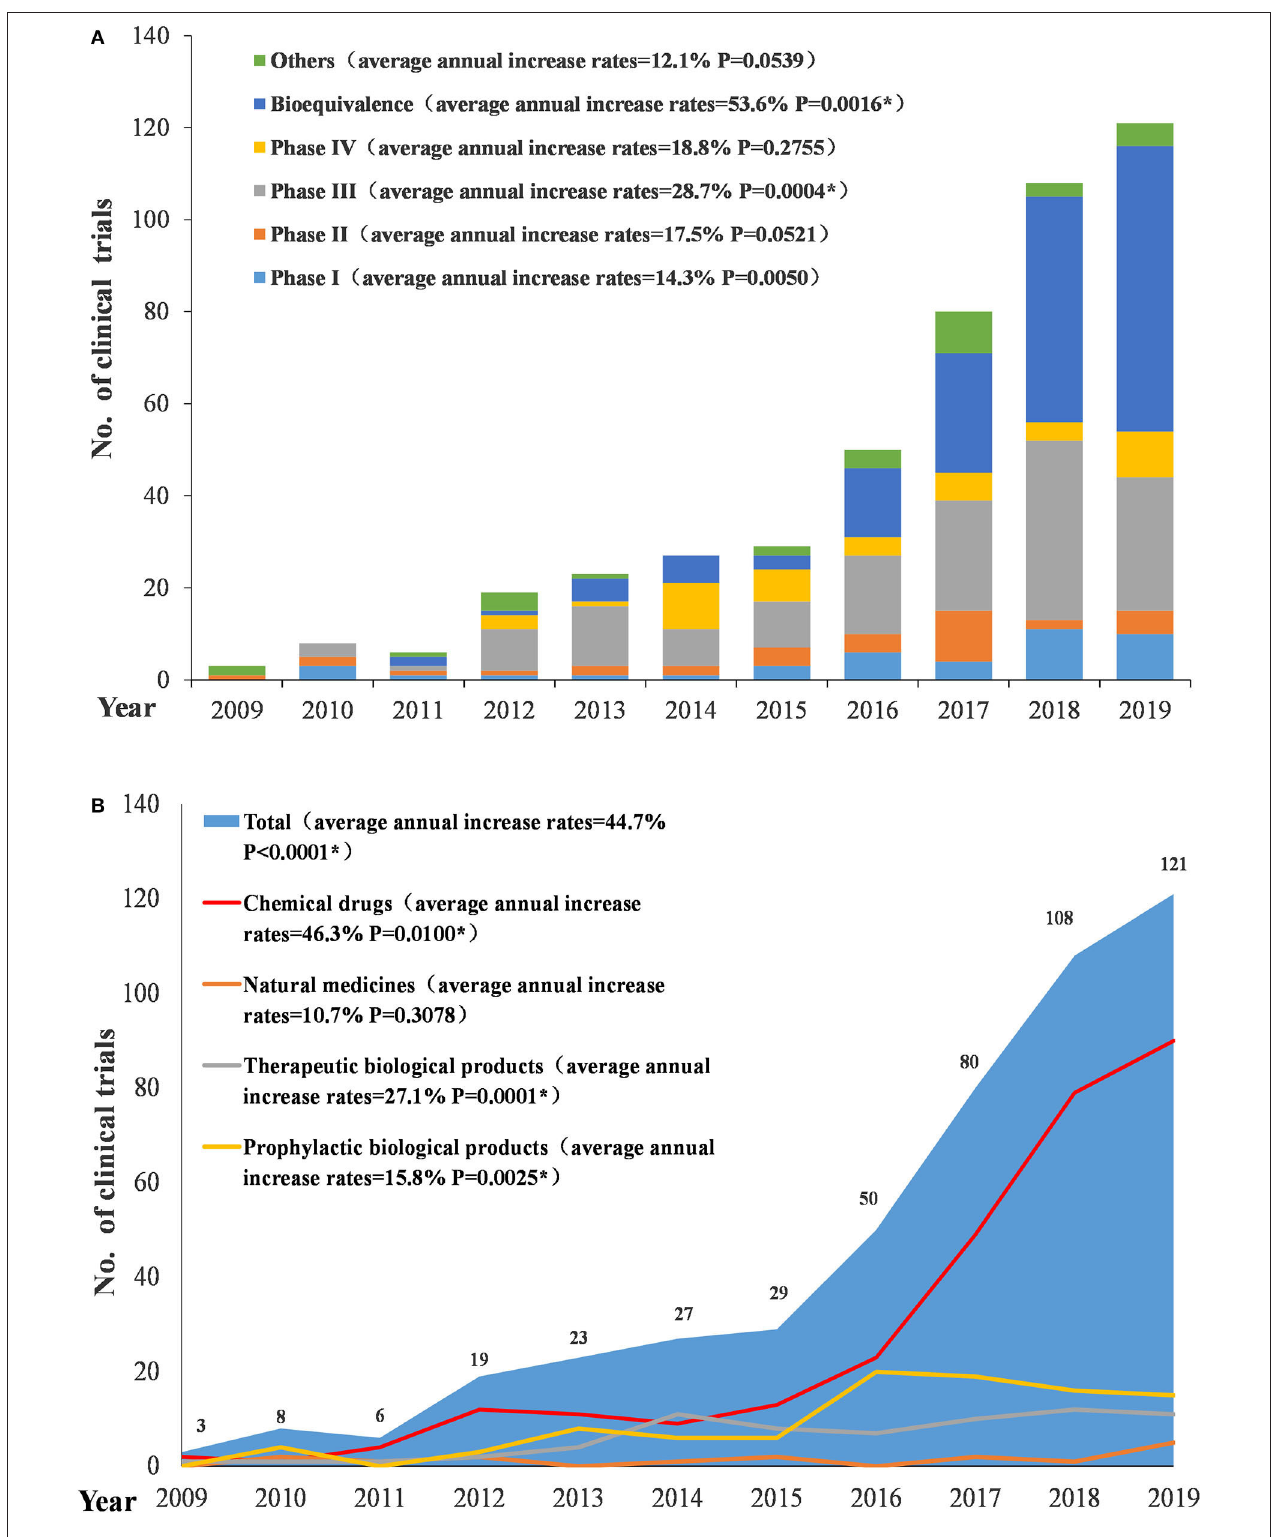
FIGURE 3 | Number and initial time of pediatric clinical trials by drug type (A) and study phase (B) .